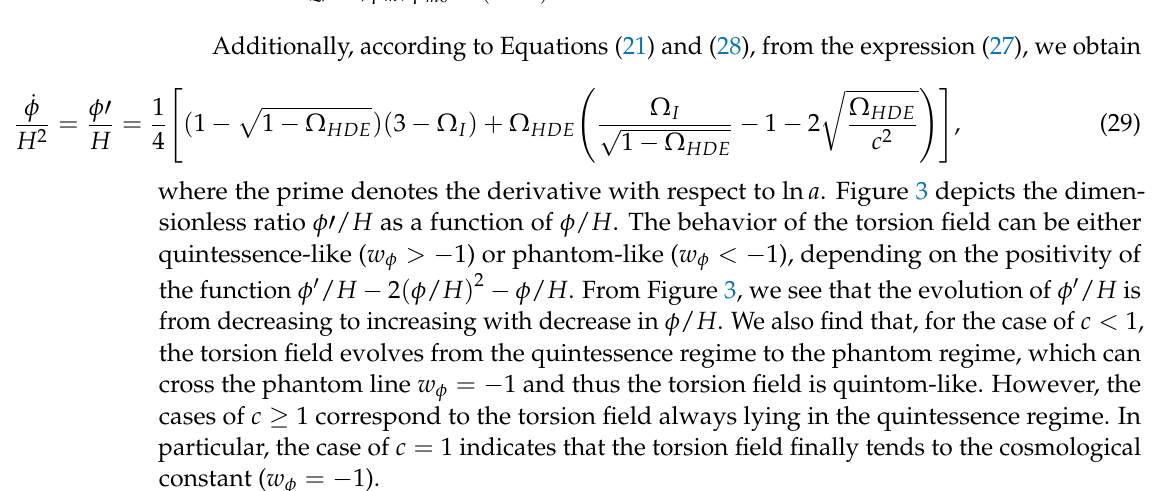
Figure 2. The evolution of the dimensionless ratio ρ m / ρ m 0 versus redshift z . The dashed line denotes the absence of Q, i.e., ρ m / ρ m 0 = ( 1 + z ) 3